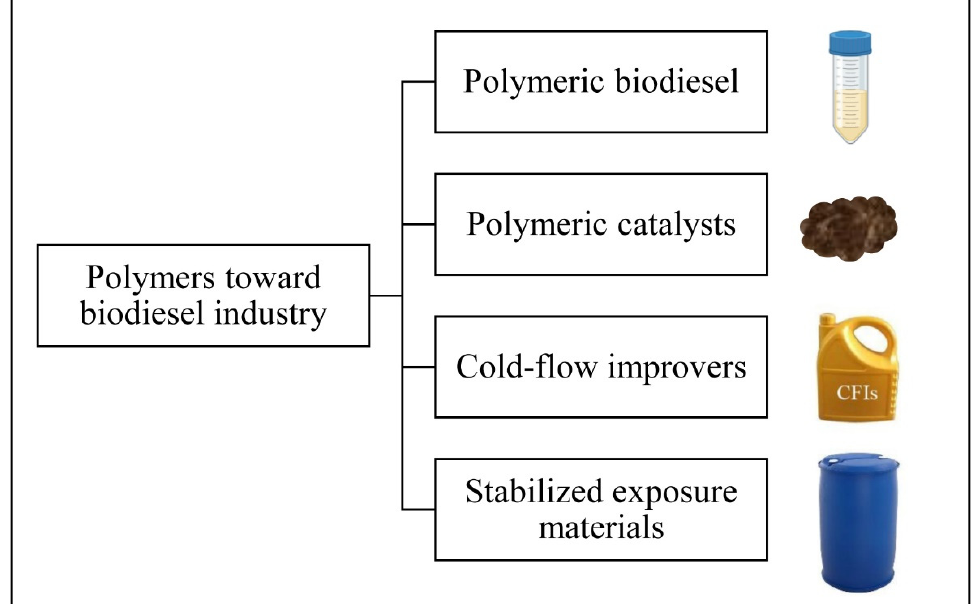
Figure 1. Utilization of polymers toward biodiesel industry.